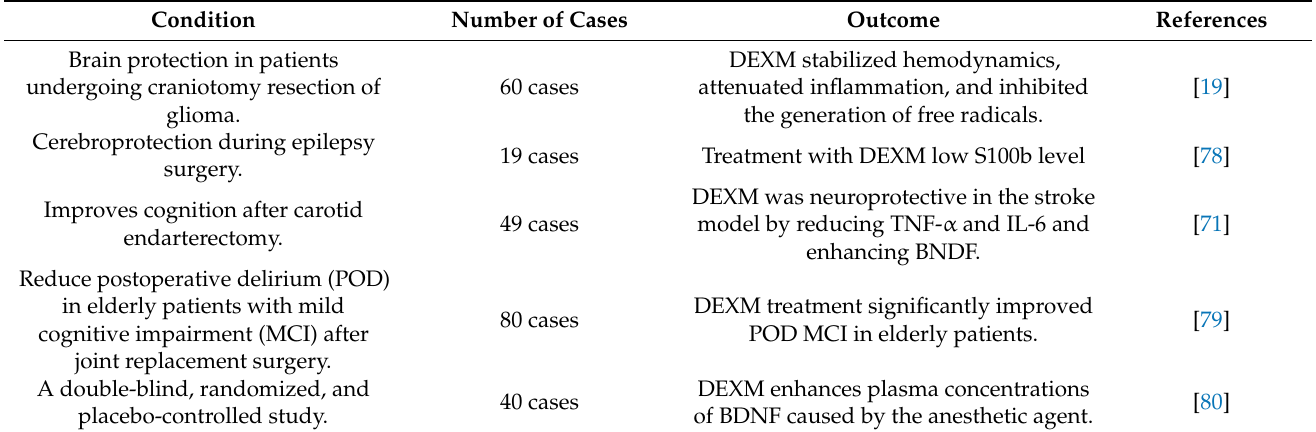
Table 3. Randomized clinical trials of Dexmedetomidine as a neuroprotective agent. Condition Brain protection in patients DEXM stabilized hemodynamics, undergoing craniotomy resection of 60 cases attenuated inflammation, and inhibited glioma. the generation of free radicals. Cerebroprotection during epilepsy 19 cases Treatment with DEXM low S100b level surgery. DEXM was neuroprotective in the stroke Improves cognition after carotid 49 cases model by reducing TNF- α and IL-6 and endarterectomy. enhancing BNDF. Reduce postoperative delirium (POD) DEXM treatment significantly improved in elderly patients with mild 80 cases POD MCI in elderly joint replacement surgery.